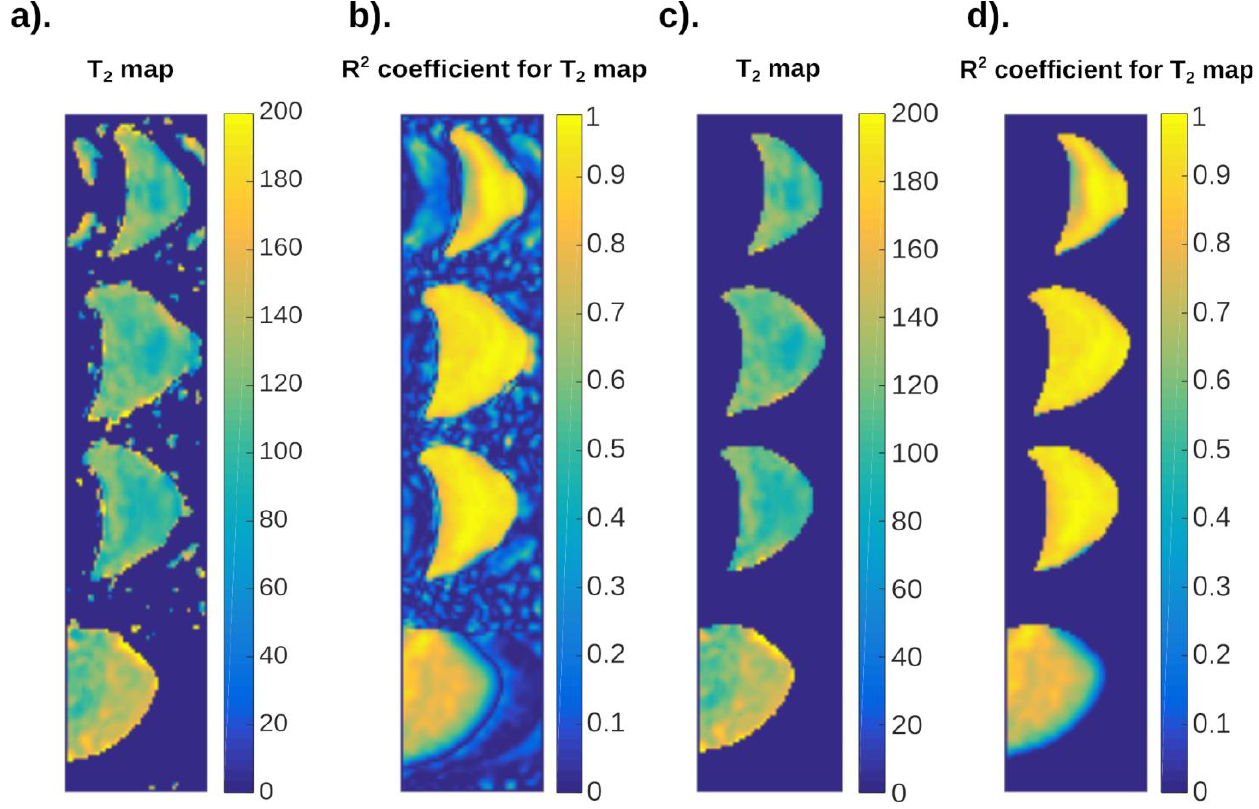
Figure 6. Practical application of neuronal analysis in cell cultures. Distribution of T 2 values for the MCF-7 cell culture: (a) Map showing the distribution of T 2 times before the neural network analysis; (b) phantom maps showing the distribution of fit coefficient R 2 values before and after the neural network analysis; (c) Map showing the distribution of T 2 times after the neural network analysis; (d) phantom maps showing the distribution of fit coefficient R 2 values before and after the neural net- work analysis. Noise reduction is clearly visible.